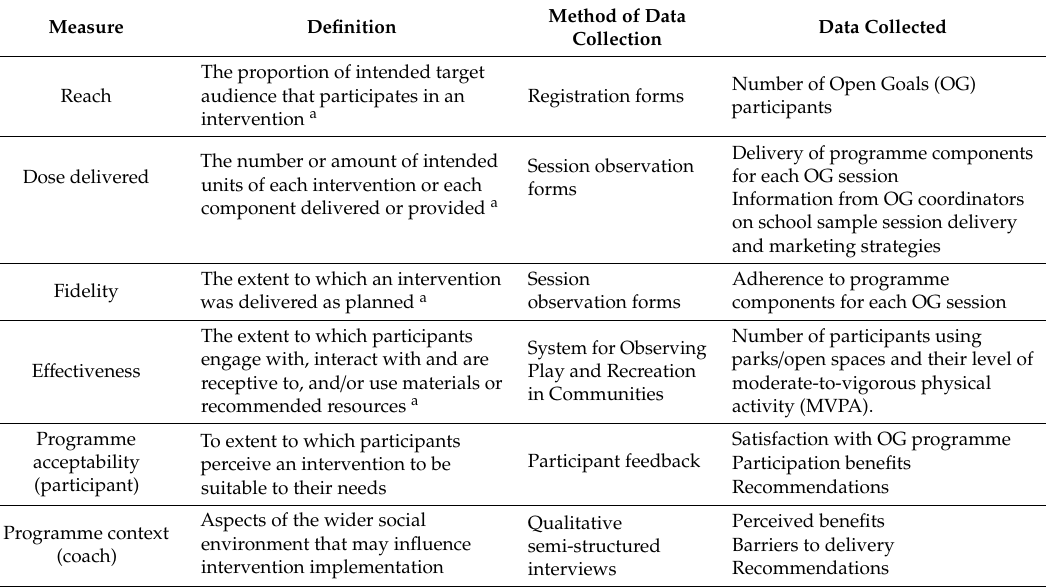
Table 1. Open Goals evaluation measures and data collection